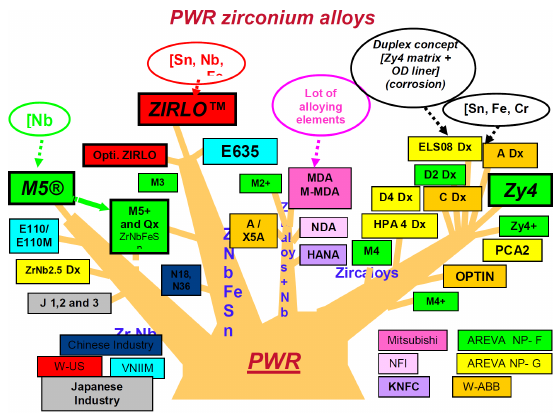
Figure 1. Nuclear fuel cladding alloys developed for usage in PWR reactors [5]. There were two main groups of cladding alloys developed: Zr-Sn (right branch) and Zr-Nb (left branch) based alloys with dozens other concepts depending on the alloying ele- ments introduced around the